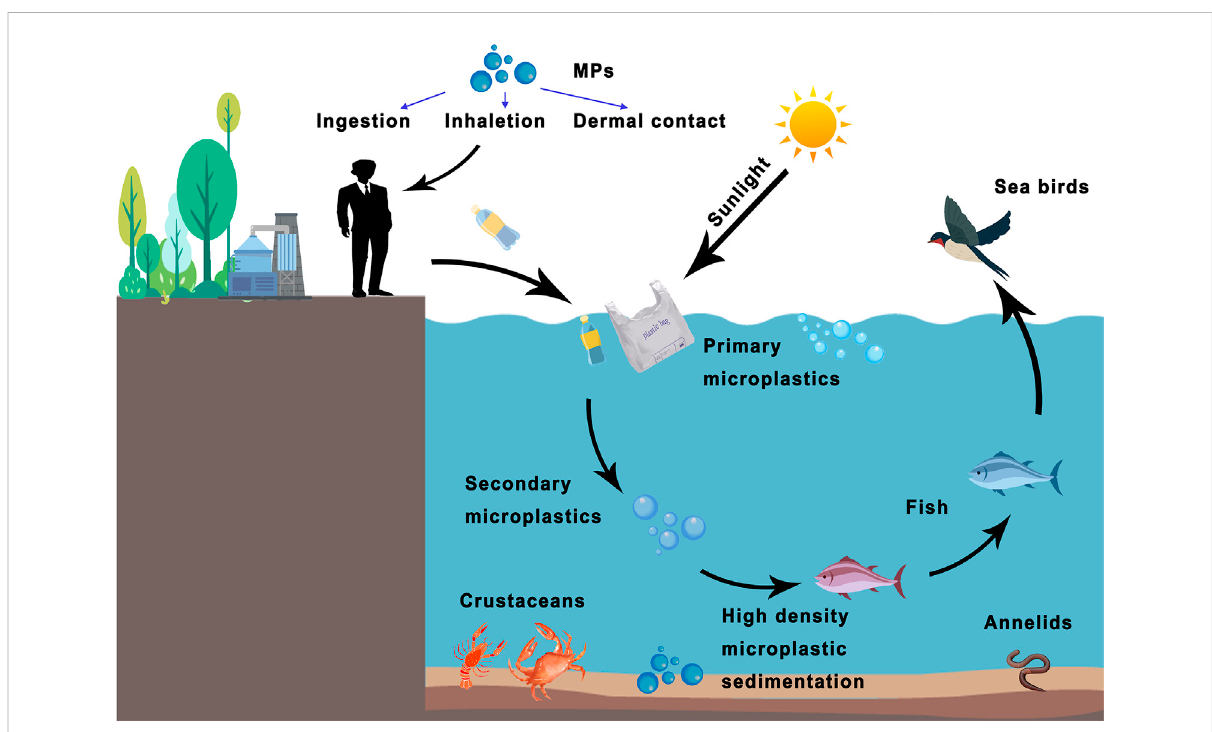
FIGURE 1 The bioconcentration of MPs in living organisms and potential human exposure ways. Plastics produced by humans are degraded into primary and secondary microplastics through seawater or sunlight. MPs can be swallowed by fi sh and passed along the food chain. Other high-density MPs become sediments that endanger marine ecology. Humans can be exposed to MPs through various routes ( e.g. , ingestion, inhalation, or dermal